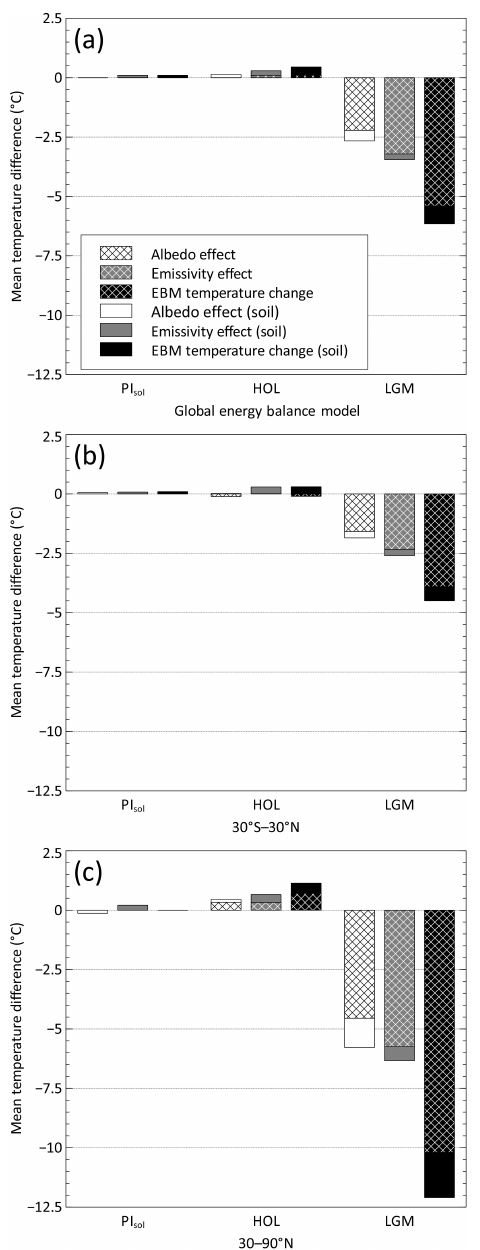
Figure 12. Application of a zero-dimensional energy balance model (EBM) on model studies of the preindustrial period (includ- ing dynamic soils, PI_sol), mid-Holocene (HOL) and Last Glacial Maximum (LGM). Panel (a) Global EBM and surface radiation di- agnostics that are used for (b) low latitudes (30 ◦ S–30 ◦ N) and (c) high northern latitudes (30–90 ◦ N). Investigations of the EBM and surface radiation diagnostics refer to model results with (blank bars) and without (hatched bars) dynamic soils with respect to the prein- dustrial period (PI_ctl). The effect of planetary albedo and effective longwave emissivity is expressed in terms of temperature